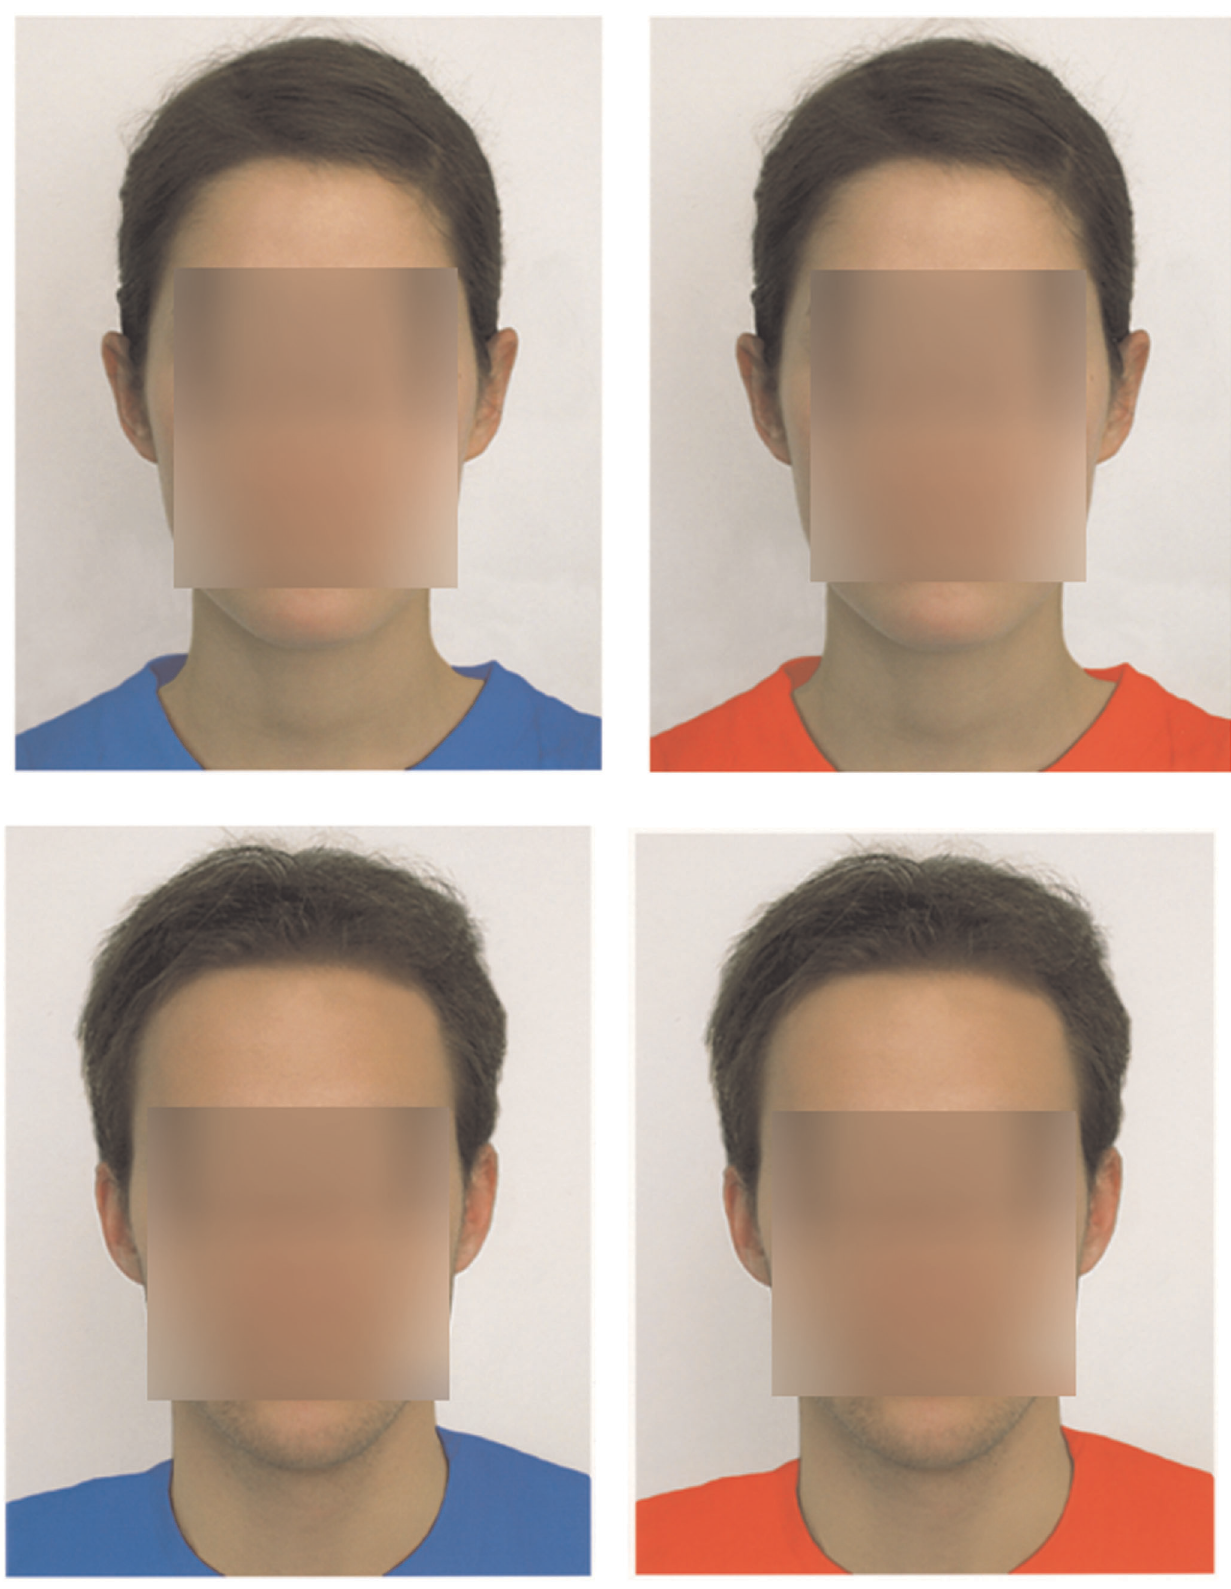
Figure 1. Pictures of ‘‘Jackie’’ and ‘‘Jack’’ in Blue and Red. The faces were intact in the experiment, but are blurred here to protect privacy.